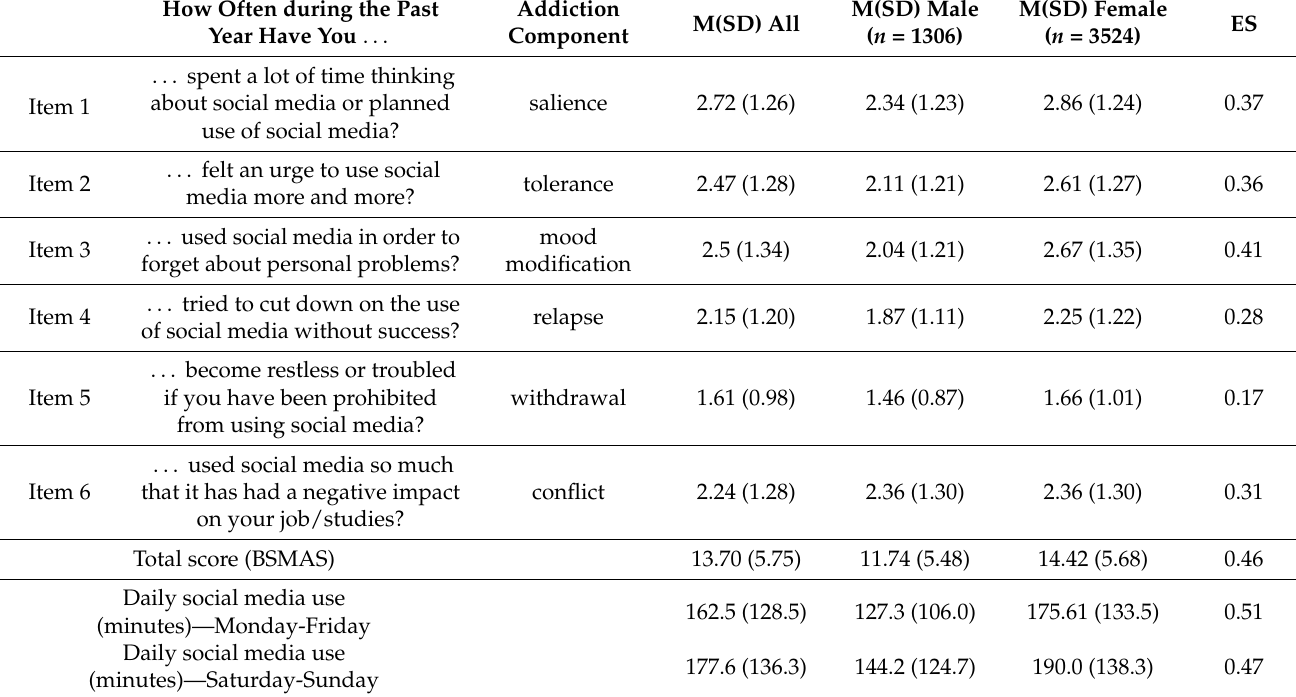
Table 2. Means and standard deviations for each BSMAS item, total score and social media use with gender differences and effect